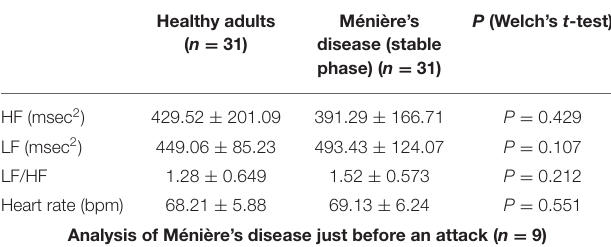
TABLE 1 | HRV power spectrum analysis in 31 patients in a stable phase of Ménière’s disease and 31 age-matched healthy adults (upper table), and HRV power spectrum analysis in a stable phase and just before an attack in nine patients whose autonomic function was able to be measured immediately before an attack (lower table).